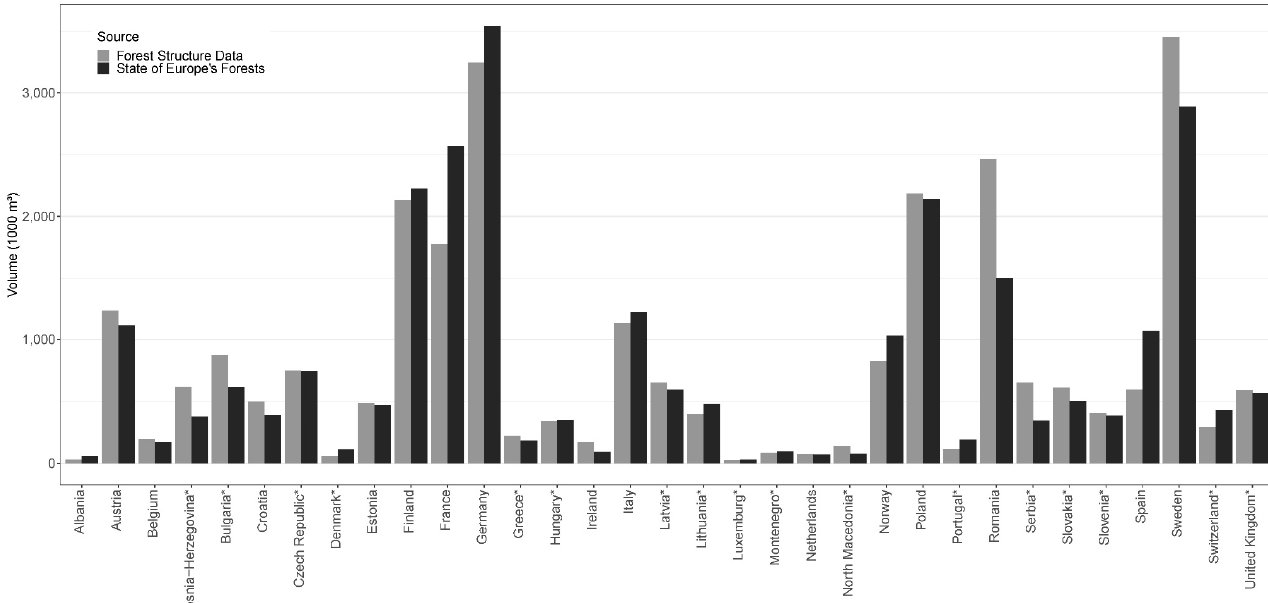
Figure 10. Comparison of the volume by country derived from our Forest Structure Data versus the mean of the volumes for the period 2000 to 2010 as reported in State of Europe’s Forest 2015 [3] (Ind 1.2B Change in growing stock on forests). Forest Structure Data refers to the values calculated by combining the gap − filled maps with land cover information to calculate country totals. Countries where no inventory data was available are marked with an asterisk.